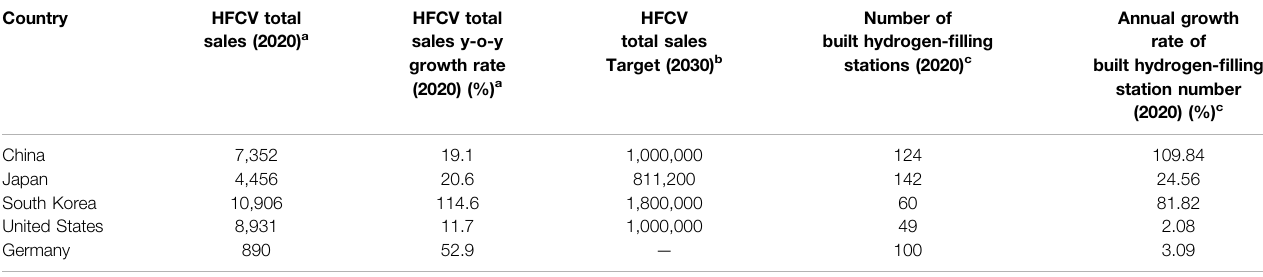
TABLE 1 | Comparison on development of HFCV industry in representative countries. Country